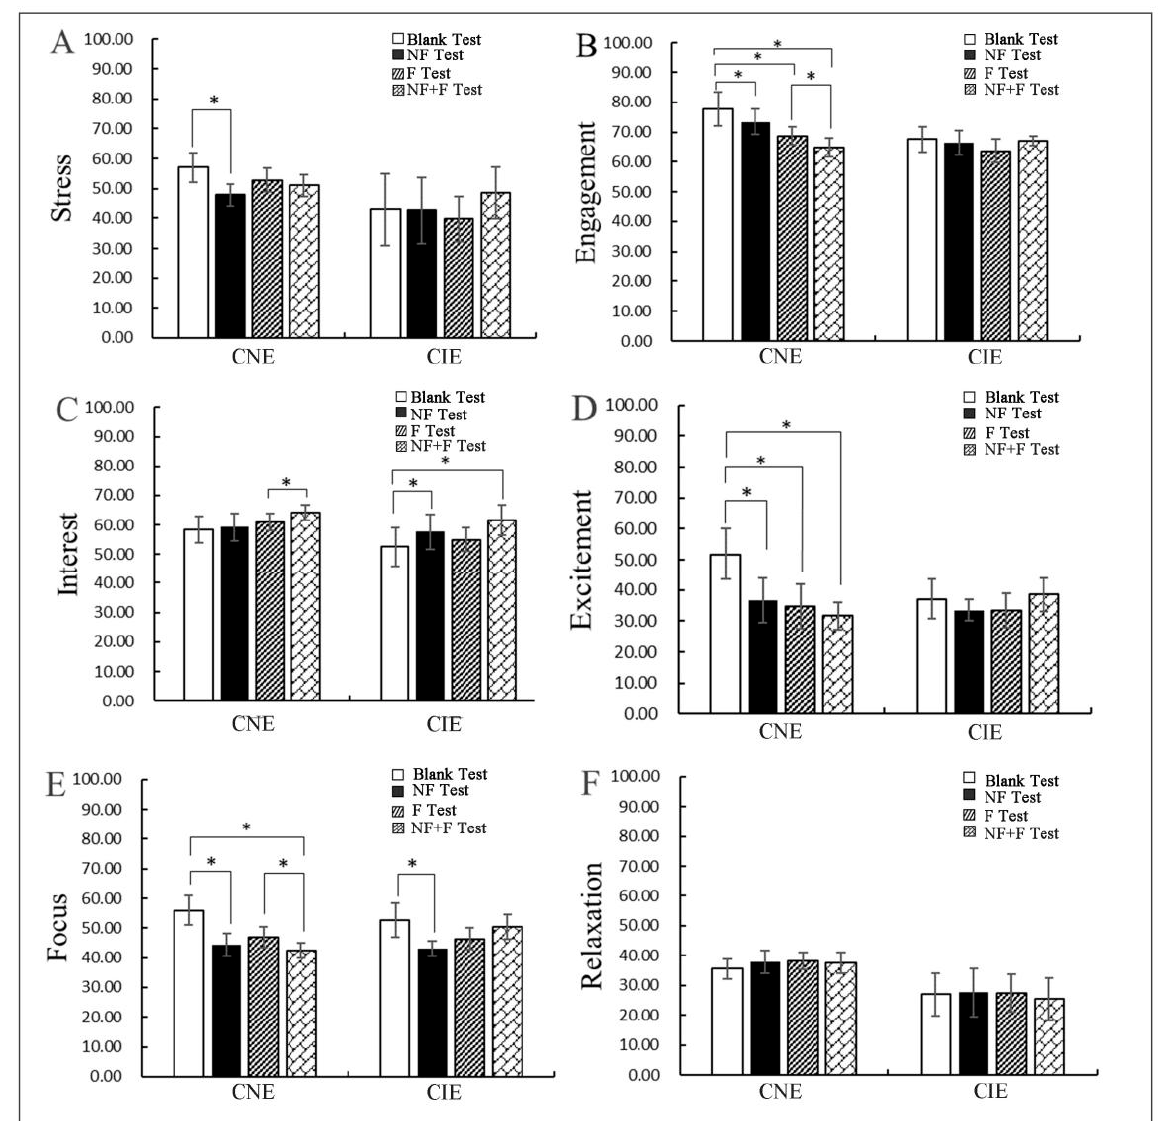
Figure 4. The analysis of the difference in significance between the tests (* sig. < 0.05); ( A ) stress, ( B ) engagement, ( C ) interest, ( D ) excitement, ( E ) focus, ( F ) relaxation.